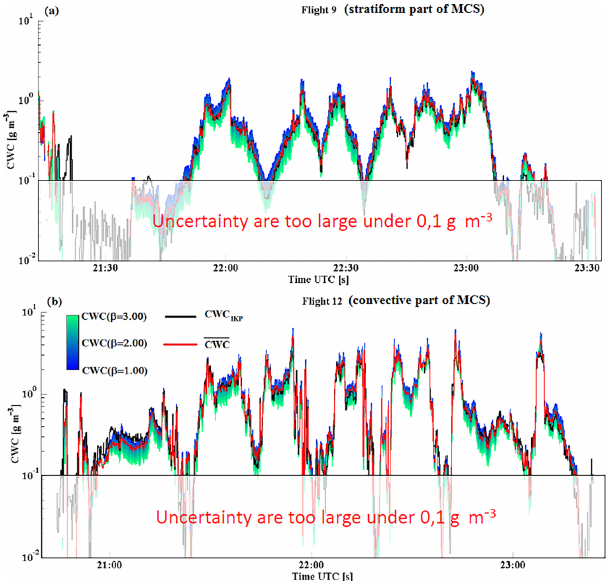
Figure 1. Condensed water content (CWC) as a function of time for two HAIC/HIWC flights during the Darwin 2014 flight campaign. In black is CWC IKP ; in red is the average CWC deduced from all possible simulations (varying β and constraining α) of the measured Z . Blue-to-green colour band shows CWC( β i ) calculations when β varies from 1 (blue) to 3 (green). (a) Results for flight 9; (b) results for flight